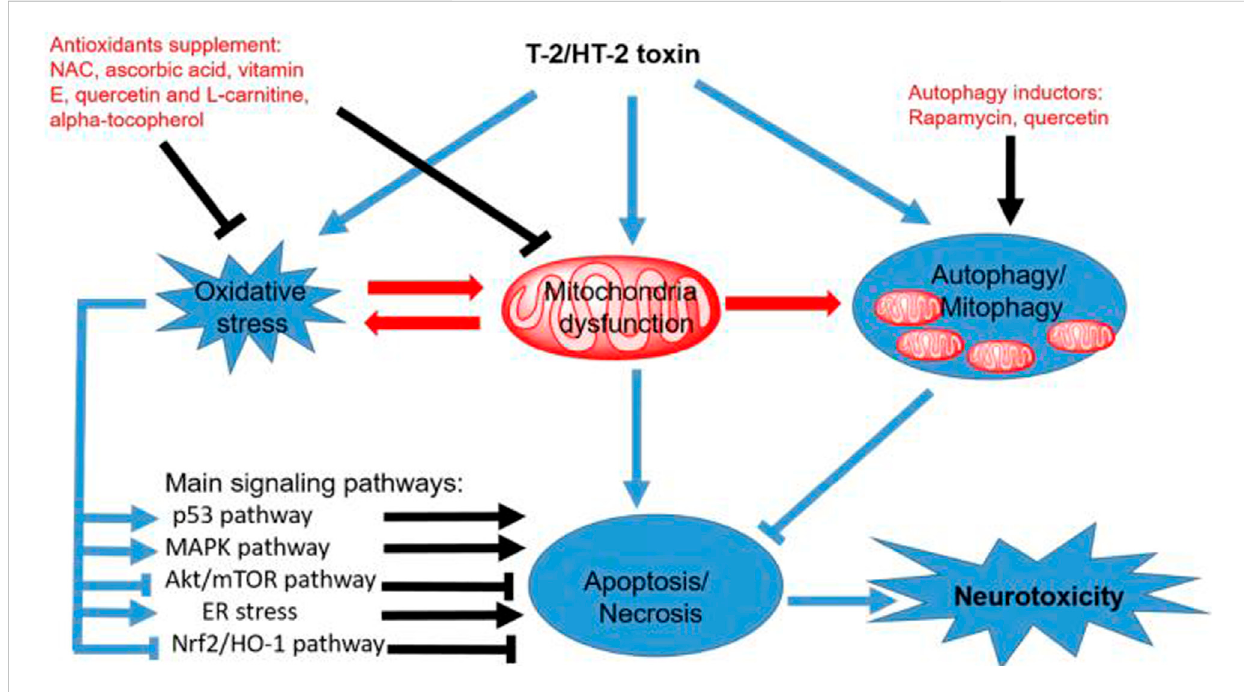
FIGURE 10 Aschematicrepresentationofoxidativestress.Mitochondrialdysfunctioniscentraltotheoxidativeprocesses,implyingthatrestoringmitochondrial functions and homeostatic requirements is crucial for optimum liver functions.